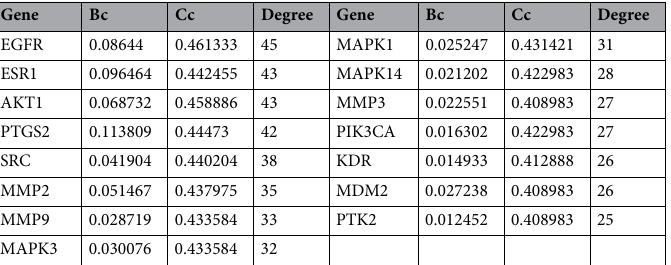
Table 2. Topological properties of hub genes.